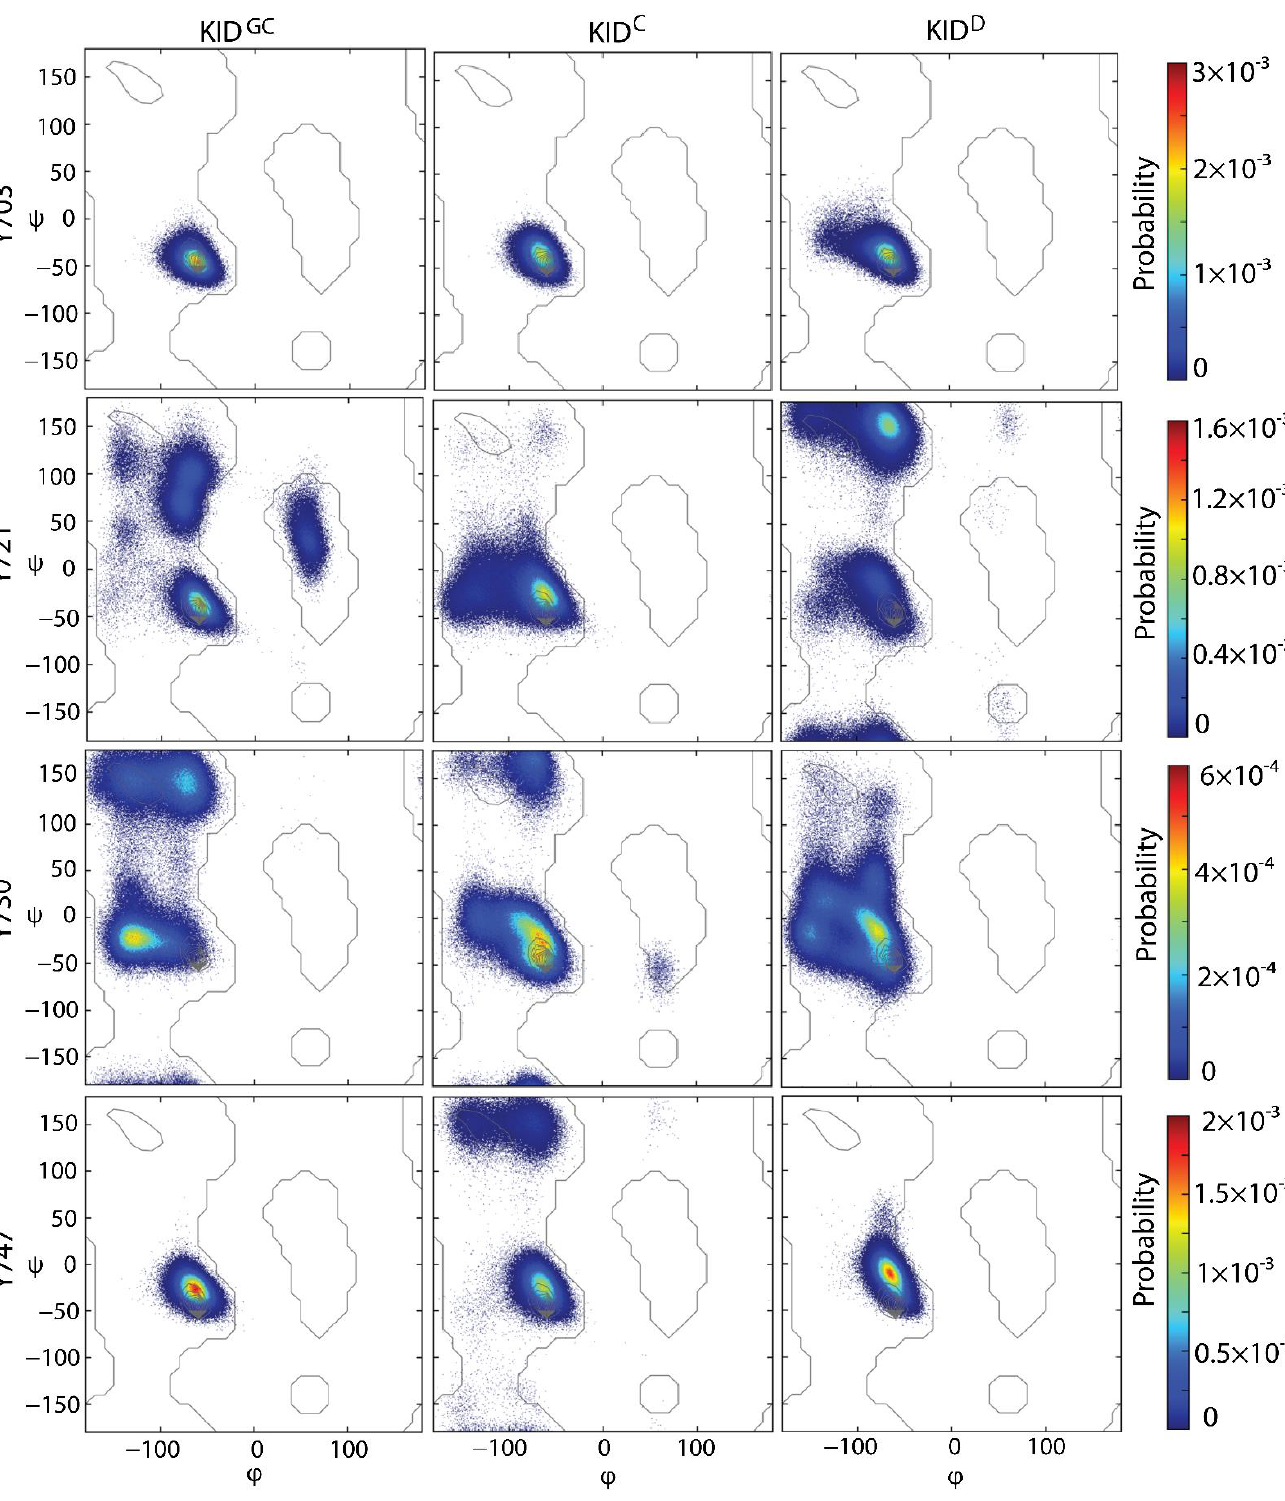
Figure 5. Ramachandran plots of the tyrosine residues in each KID entity. The colour scale shows the population density. Contours represent the unphosphorylated tyrosine backbone-dependent authorized regions [46]. The red colour represents high occurrence, yellow and green represent low, and blue represents the lowest occurrence.